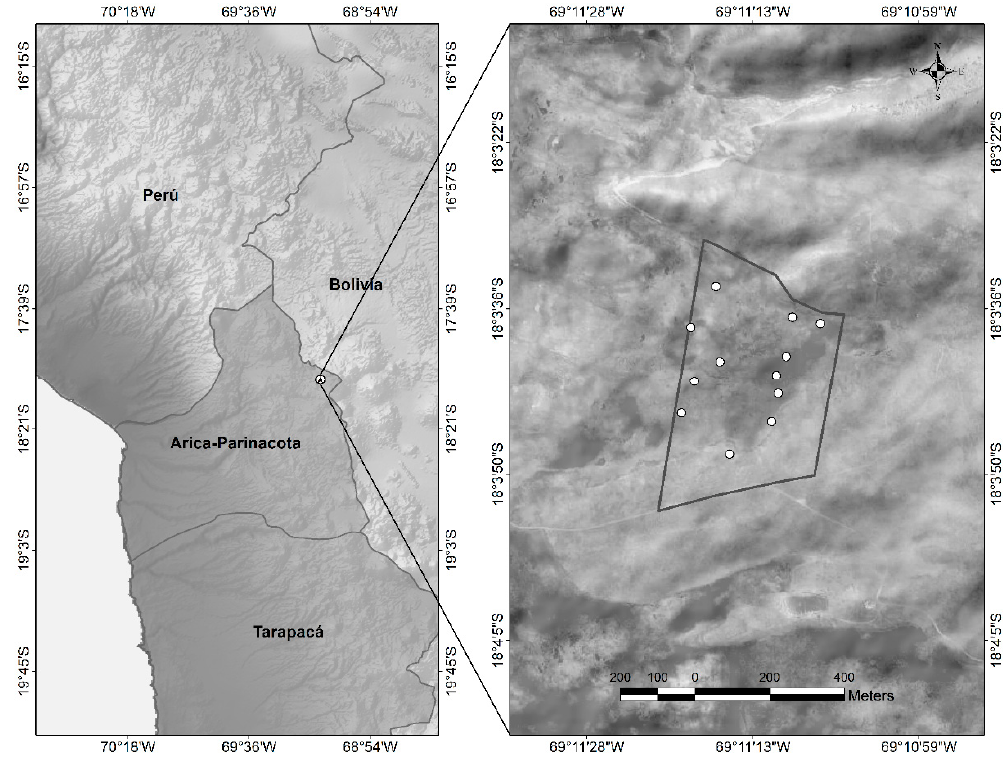
Figure 2. Location of the experimental area and distribution of the feces piles within the area grazed by vicuñas.